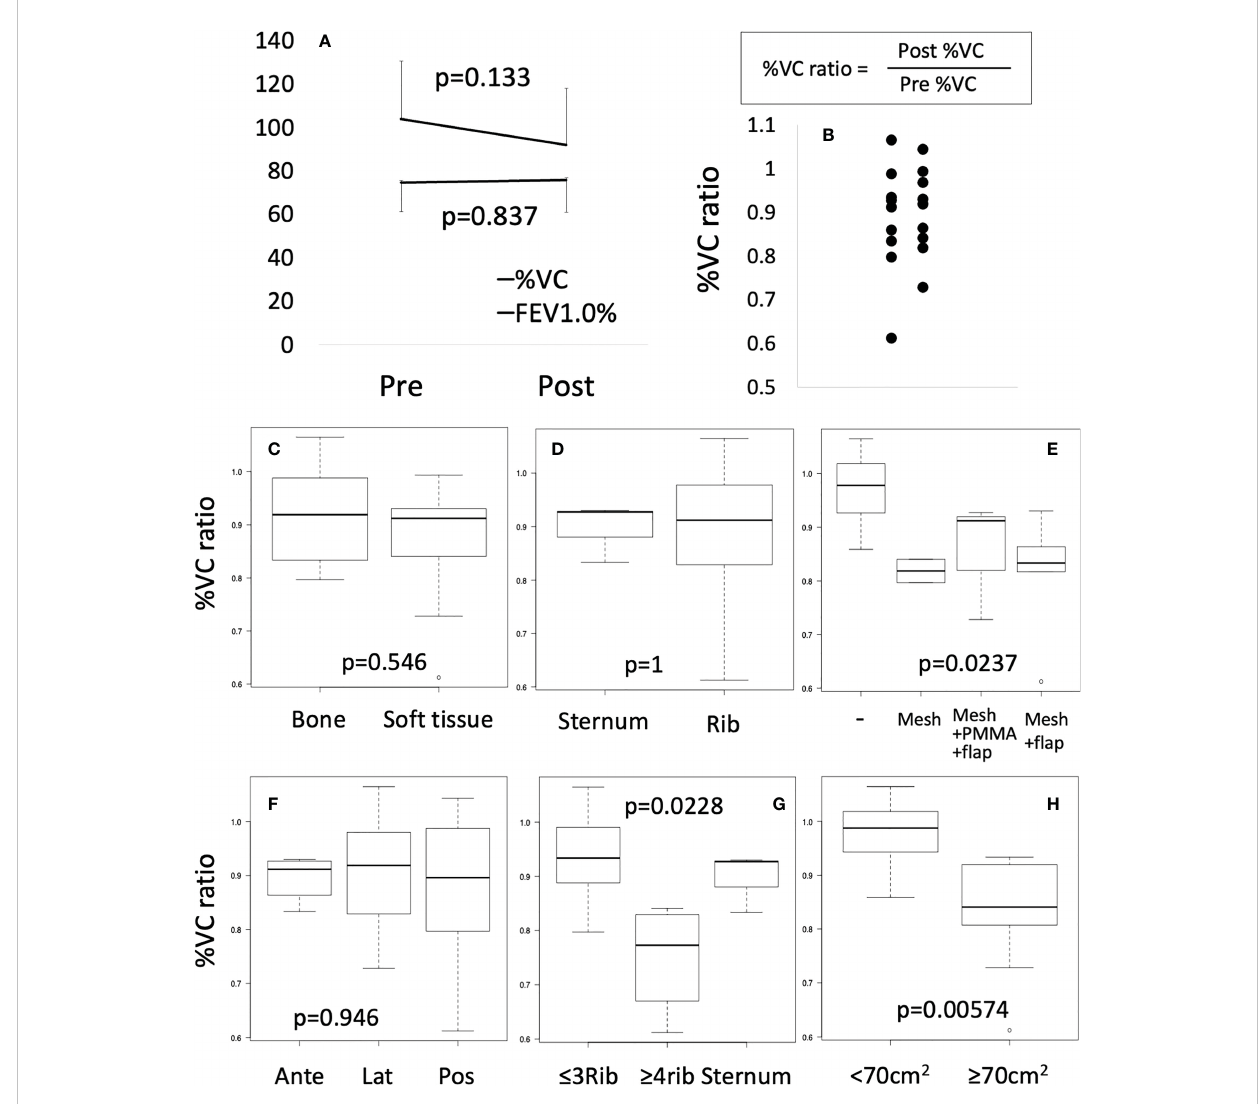
FIGURE 2 Pulmonary function test. (A) Preoperative (Pre) or postoperative (Post) %VC and FEV1.0% were compared by Mann-Whitney test. (B) %VC ratio was shown by scatter plot. (C – H) Box plots were shown. Mann-Whitney test or Kruscal-Wallis test were